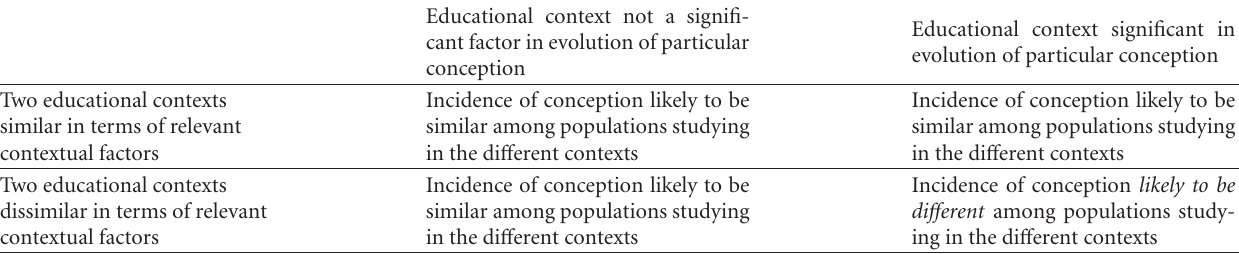
Figure 2: The potential of surveys as part of an ongoing research programme (Redrawn after [2]). Table 1: Conditions for expecting di ff erent frequencies of common conceptions among students in distinct